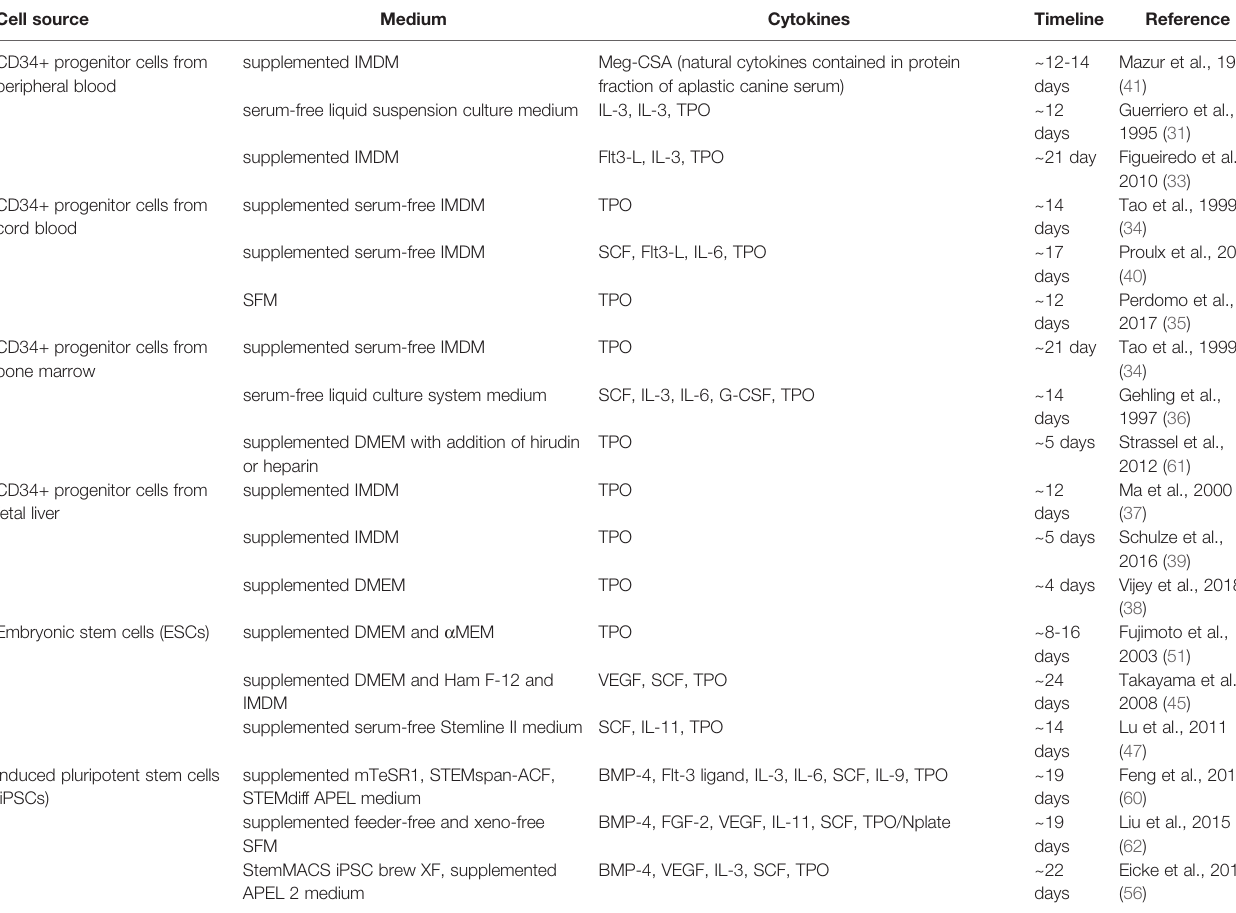
TABLE 1 | Strategies to differentiate MKs and PLTs in vitro